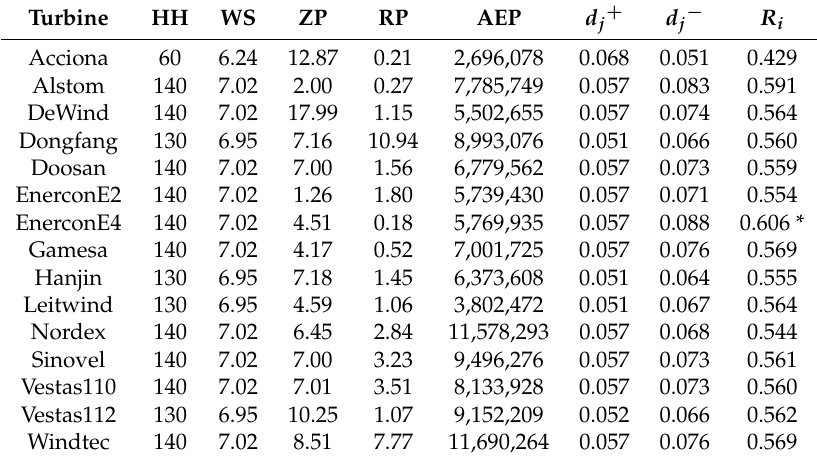
Table 3. Best tradeoff for each turbine for Turaif. The best turbine among all is marked with an